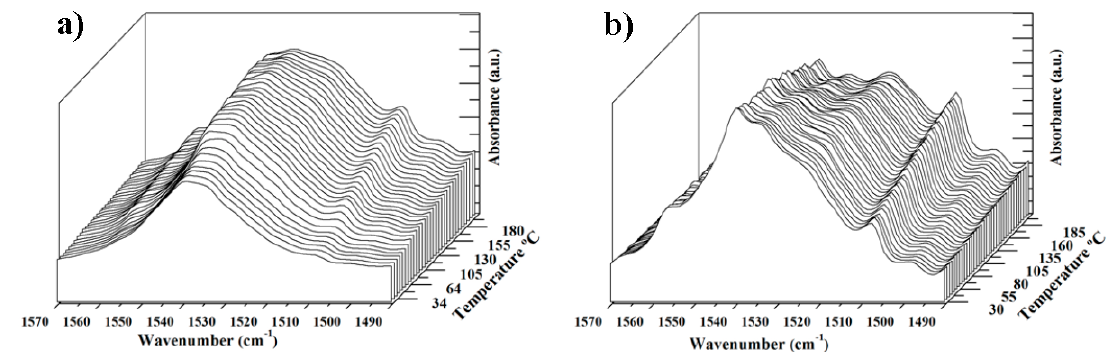
Figure 11. Temperature evolution of the 1570–1485 cm − 1 region of the FTIR spectra of: solution crystallized ( a ); and melt crystallized ( b ) nylon 4 9 samples.